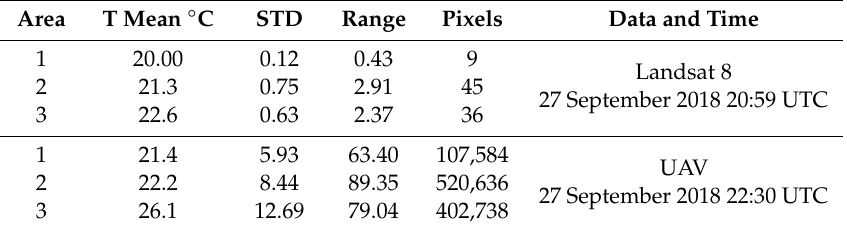
Table 5. Statistical analysis for September 2018.